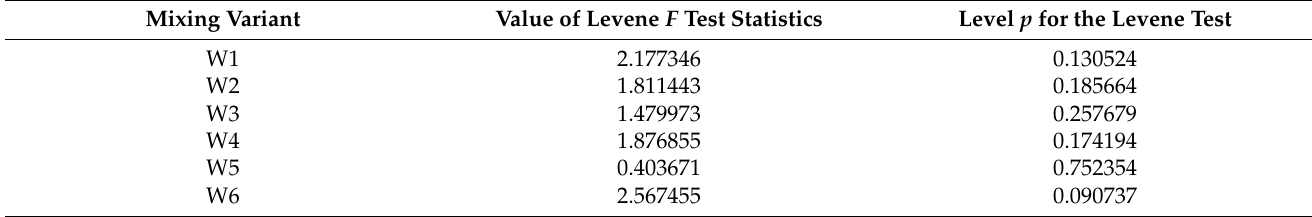
Table A2. Results of Levene test of tensile strength of adhesive compositions in grouping into mixing methods.